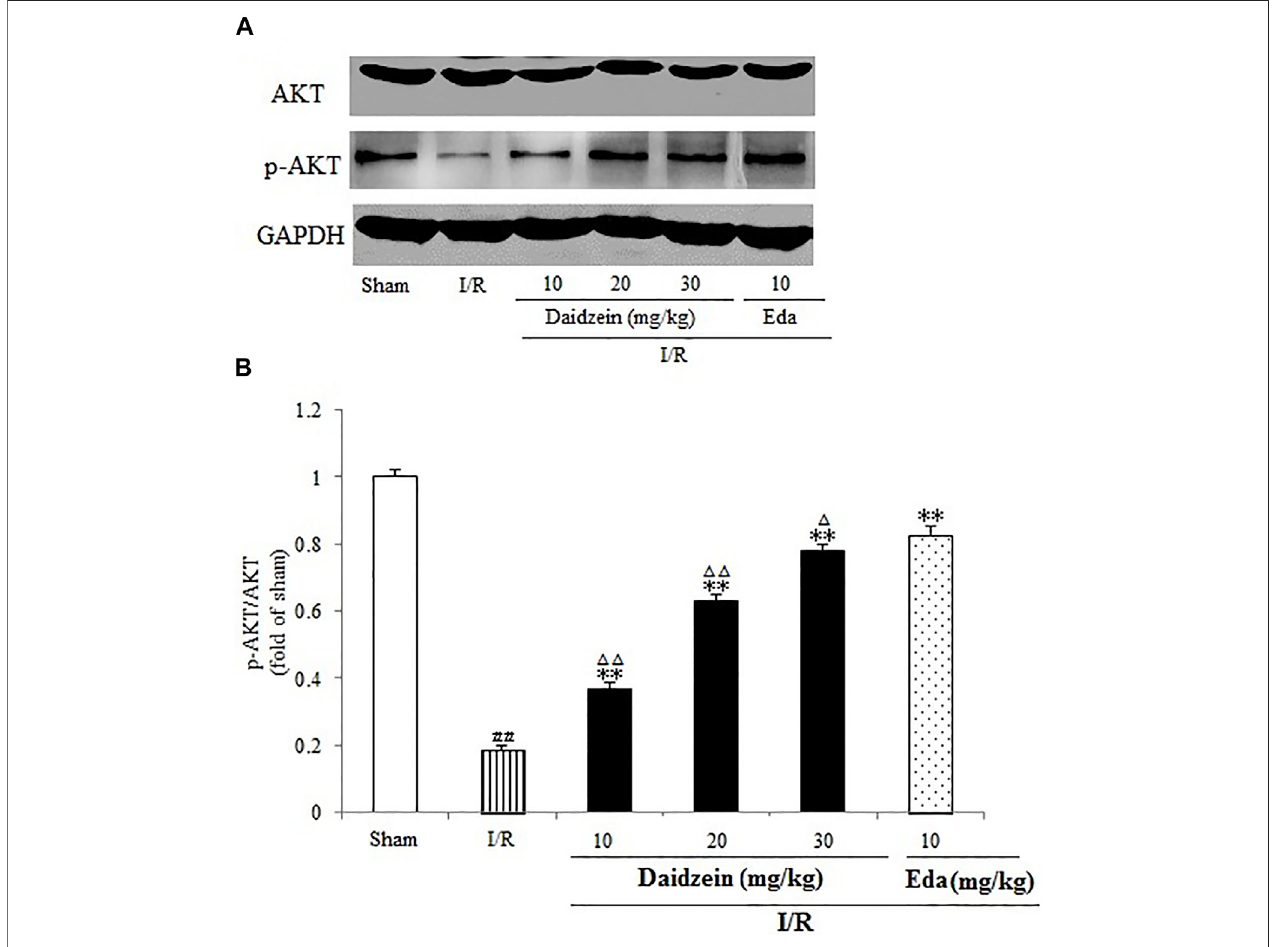
FIGURE6| Effectsdaidzeintreatmentontheexpressionofp-AktandAktlevelsinrats ’ braininfarctregion. (A) Representativewesternblots. (B) Ratioofp-Akt/Akt. Valuesareindicatedasmeans ± standarderrorsofthemeans(SEMs; n (cid:2) 3). ## p < 0.01noticeablydistinctfromSham;** p < 0.05,noticeablydistinctfromI/R; △ p < 0.05, △△ p < 0.01, compared with the Eda